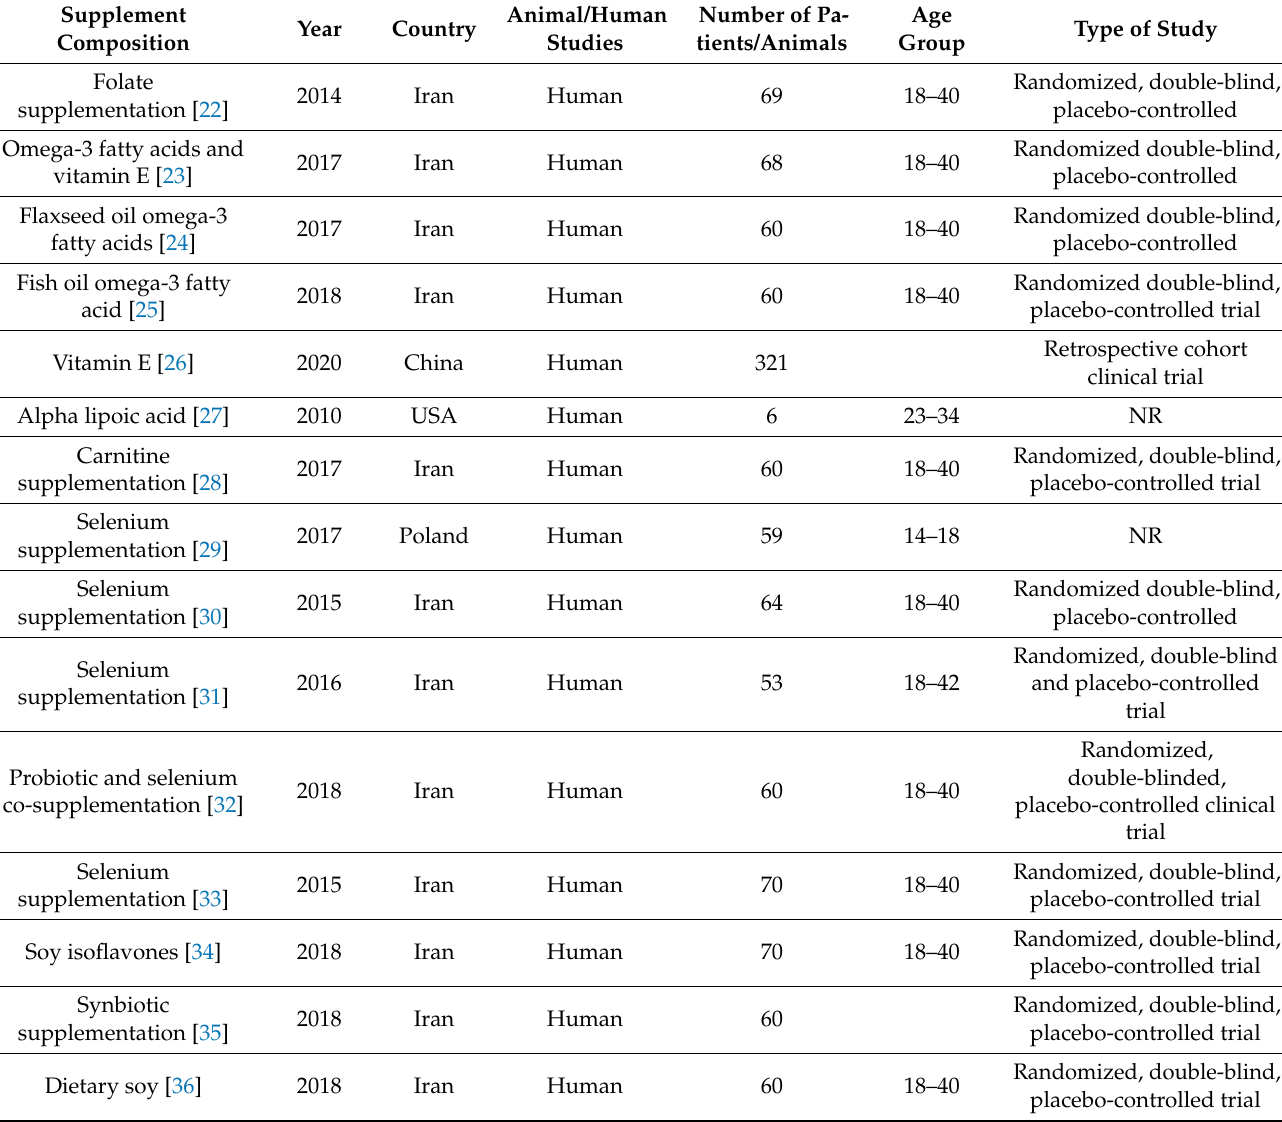
Table 1. Studies performed on supplementation in human and mice